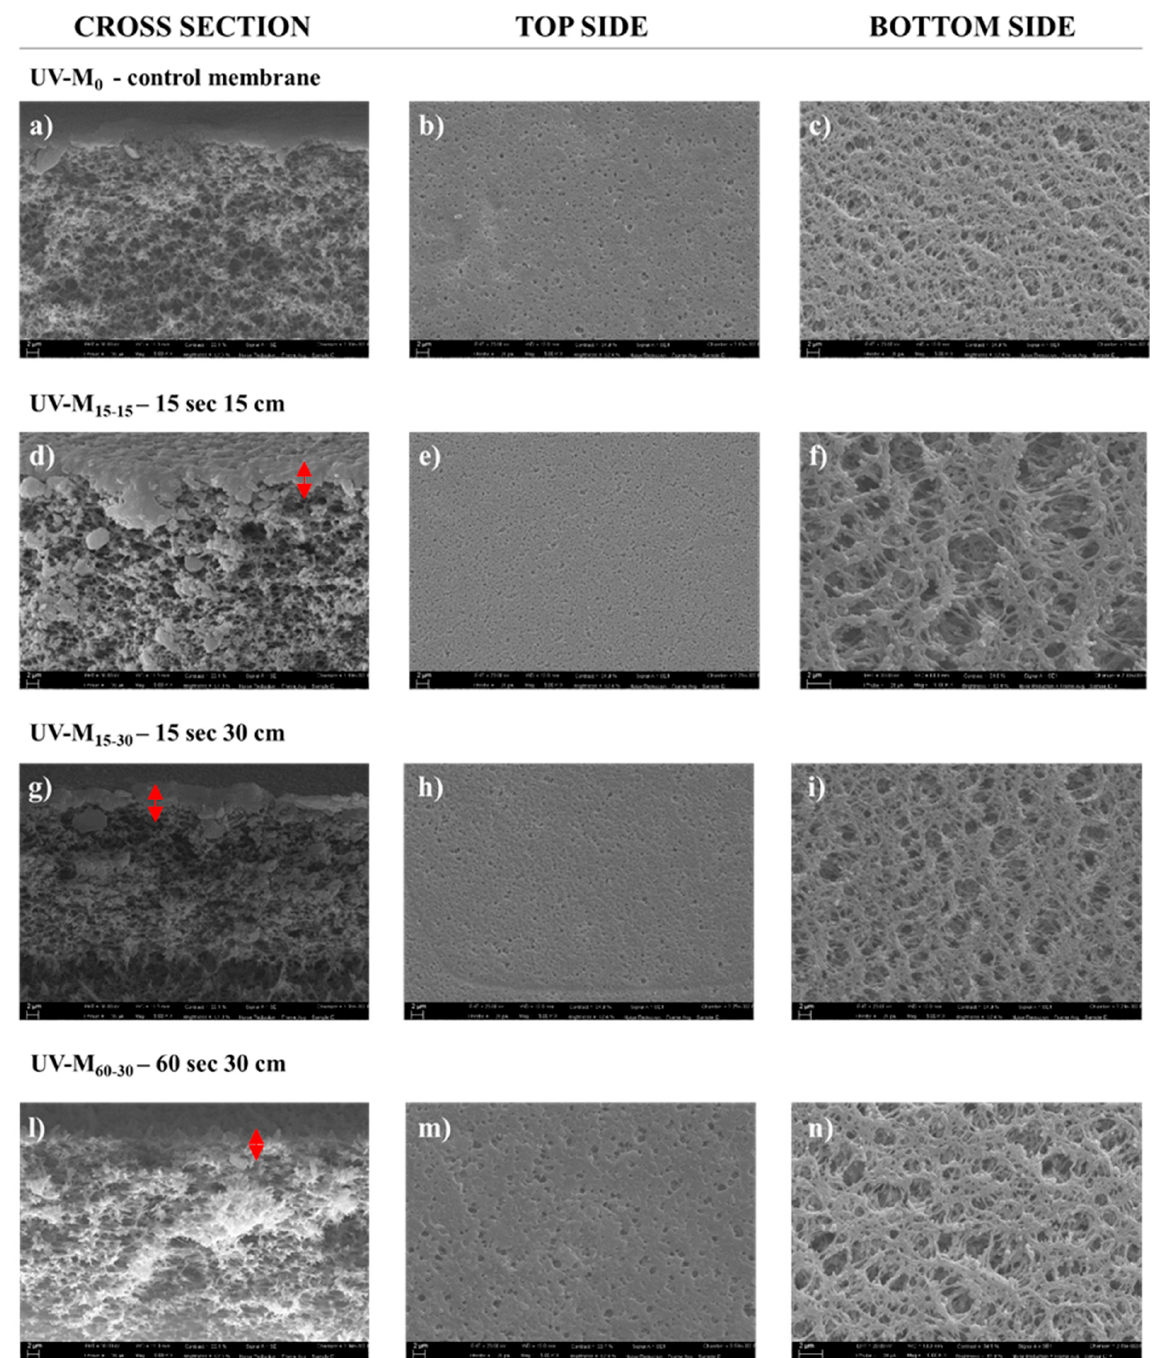
Figure 3. SEM images (cross-section, top side, and bottom side) of the ( a – c ) UV-M 0 control membrane; ( d – f ) UV-M 15-15 membrane; ( g – i ) UV-M 15-30 membrane; and ( l – n ) UV-M 60-30 membrane (magnification of 5.00 KX for cross-section and top side, and 10.00 KX for bottom side).